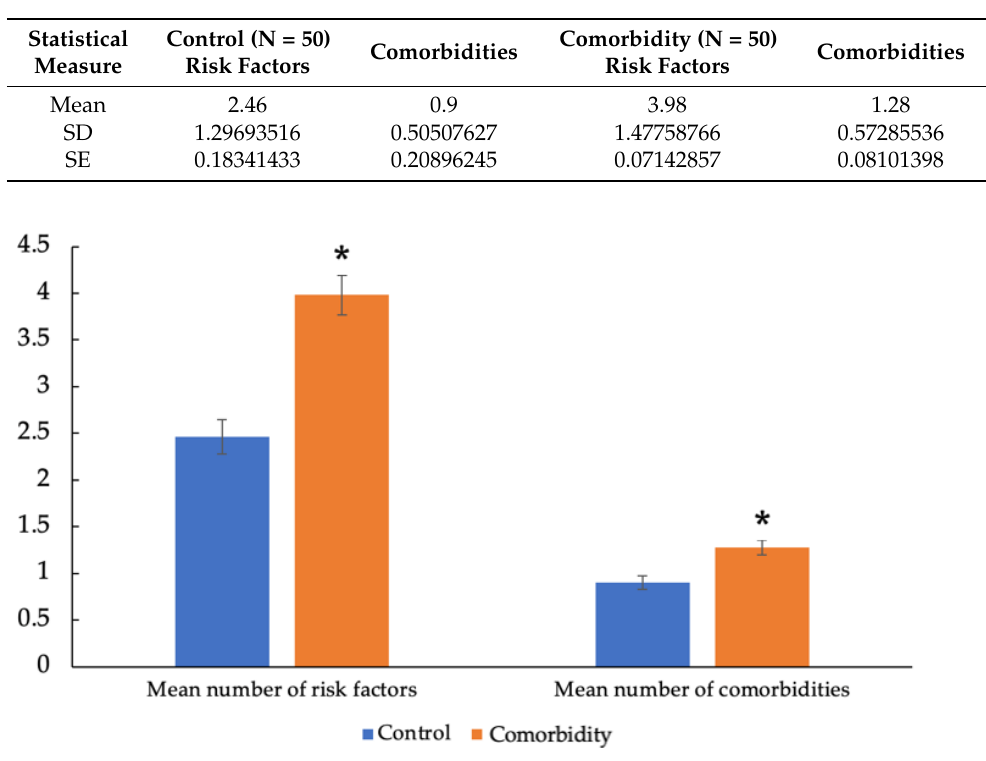
Table 7. Mean number of risk factors and comorbidities of participants in the control and comorbidity groups with standard deviation and standard error calculations.